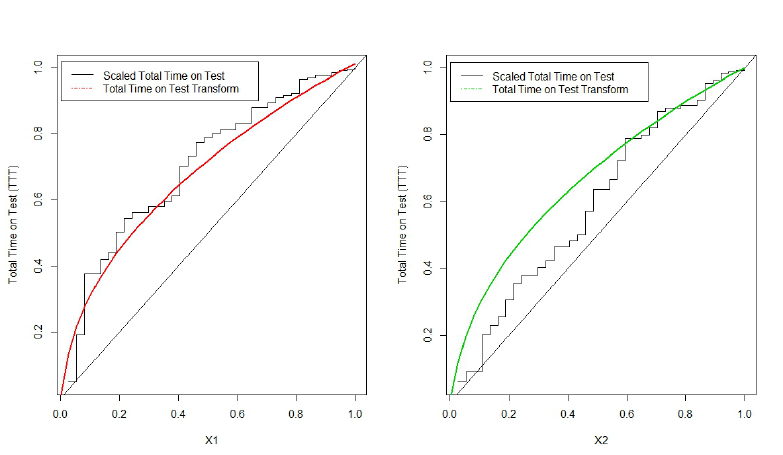
Figure 9 – TTT-plot of UEFA Champion’s League data.